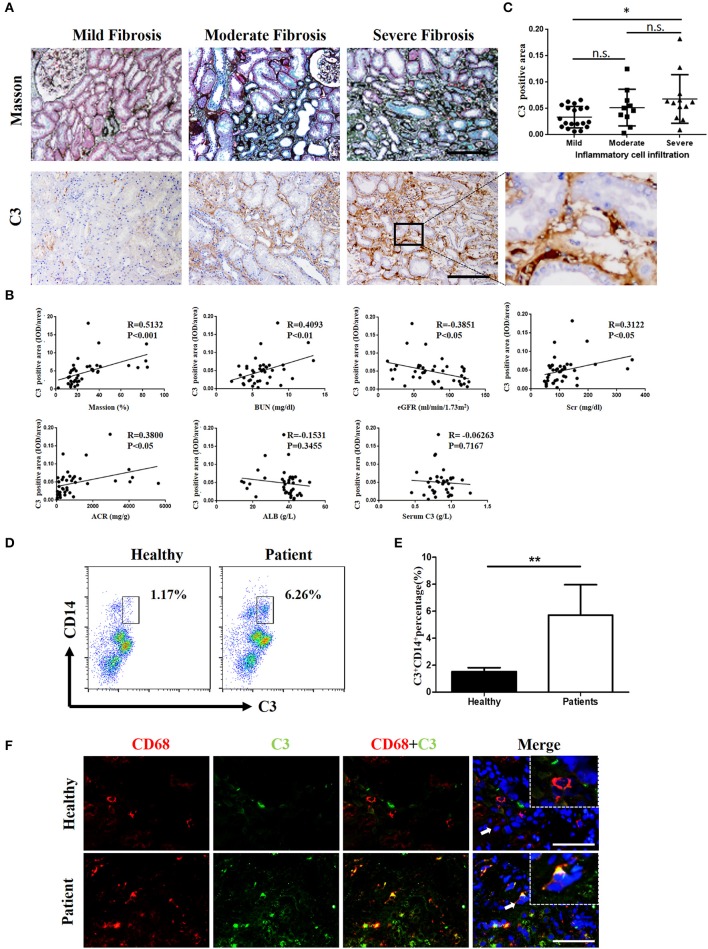
C3 levels were increased in renal tissues and blood samples from patients with IgAN (A) Masson's trichome staining showing collagen deposition; IHC analysis of C3 expression in the kidney. n = 41 patients with IgAN. (B) Relationships between C3 in the interstitium with Masson's trichome staining, BUN, the eGFR, Scr, ACR, ALB, and serum C3. (C) Relationships between C3 in the interstitium with the degree of inflammatory cell infiltration. Error bars represent SEM. *P < 0.05. (D) Flow cytometric analysis showing the percentages of C3+CD14+ in PBMC of patients with IgAN. The data shown are representatives of FACS profiles. (E) The histograms show the increased the percentages of C3+CD14+ in peripheral blood mononuclear in the IgA patients (n = 41) compared with the healthy (n = 37). The error bars represent the SEM. **P < 0.01. (F) Immunofluorescence staining of CD68 (red) and C3 (green) in the kidney. Scale bar, 50 μm.